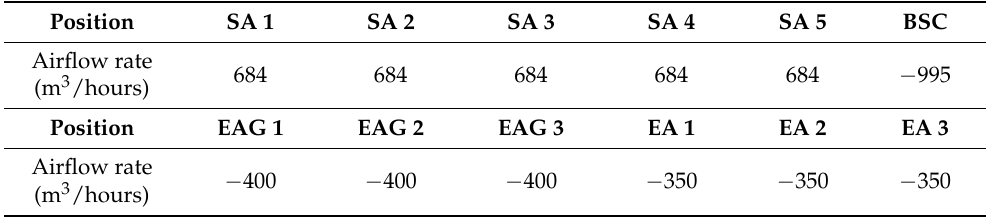
Table 2. Airflow rates obtained from field measurements for the boundary conditions.